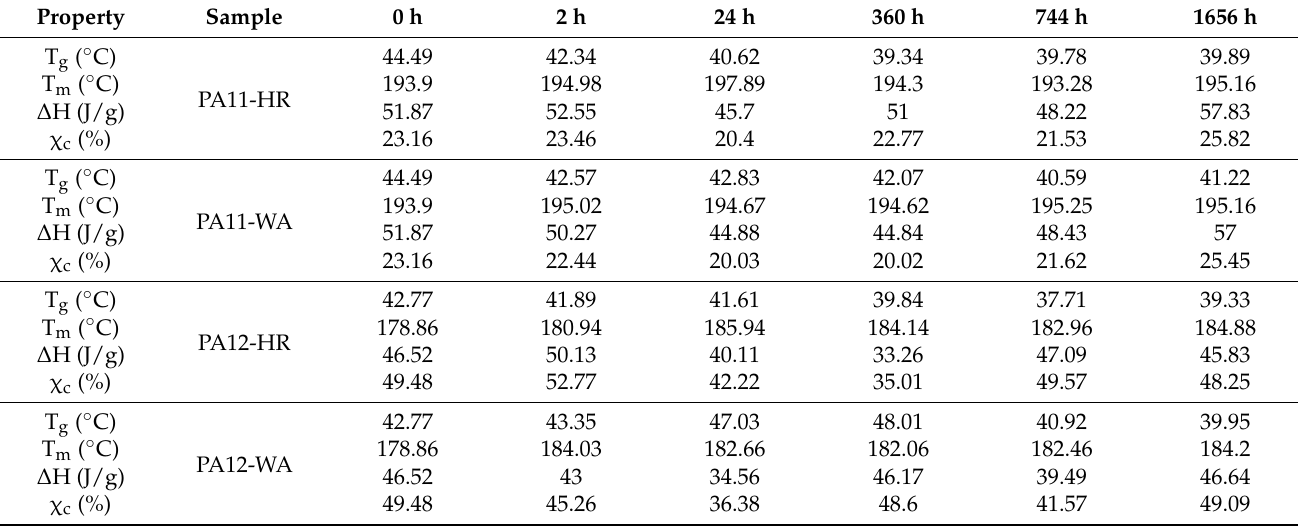
Table 6. Thermal properties of studied polyamides by DSC after the durability test.